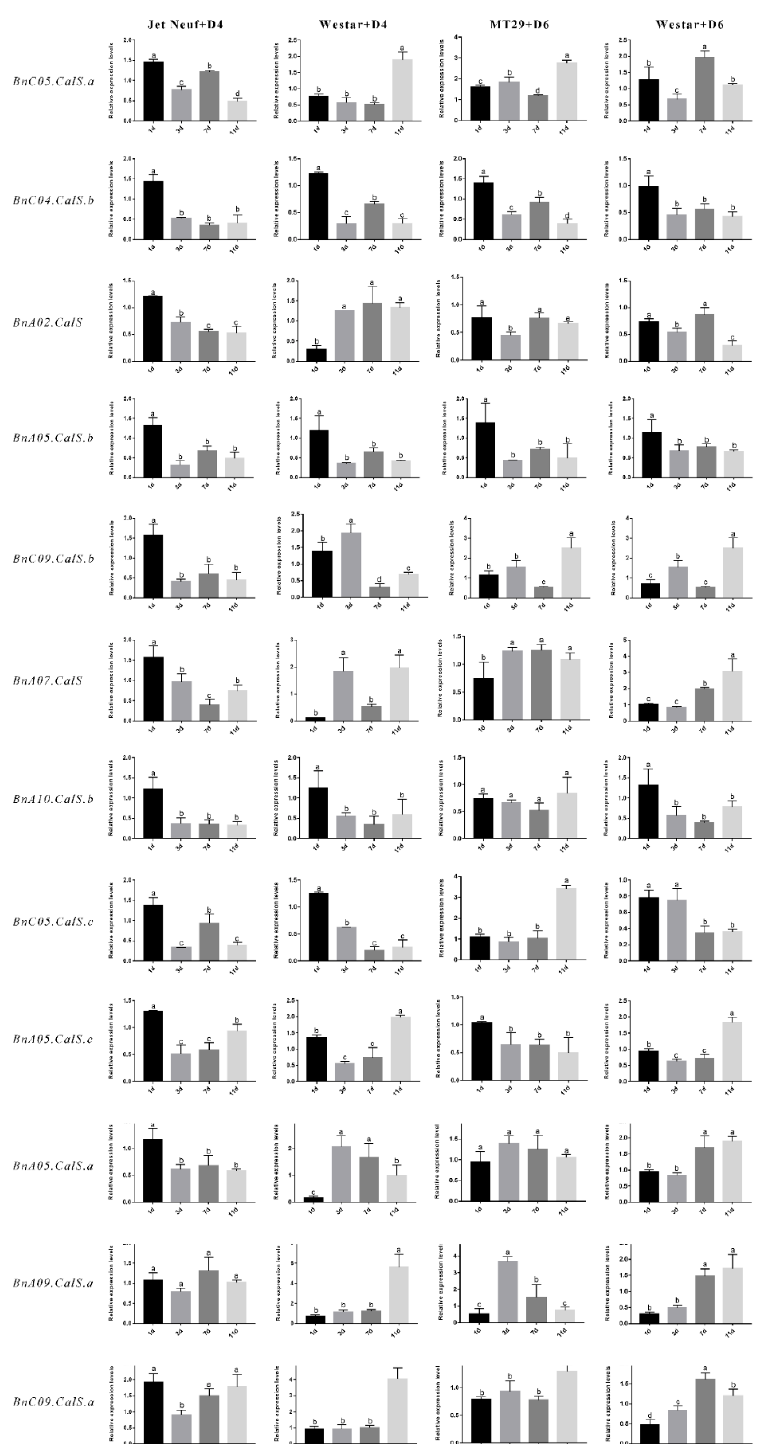
Figure 8. Expression analysis of selected 12 BnCalS genes in two B. napus varieties following inoculation with Leptosphaeria maculans . Three different varieties, Westar, MT29, and Jet Neuf, were inoculated with two L. maculans isolates, D4 and D6, and expression of the corresponding 12 CalS genes at different time points was determined using qPCR. The Brassica napus Actin gene was used as the internal control to normalize expression data. The results were calculated from three biological replicates. Tukey’s test (ANOVA) were performed to determine the significant difference between each treatment. The statistically significant differences were defined as p < 0.05 and are marked with different letters. Error bars denote standard error.